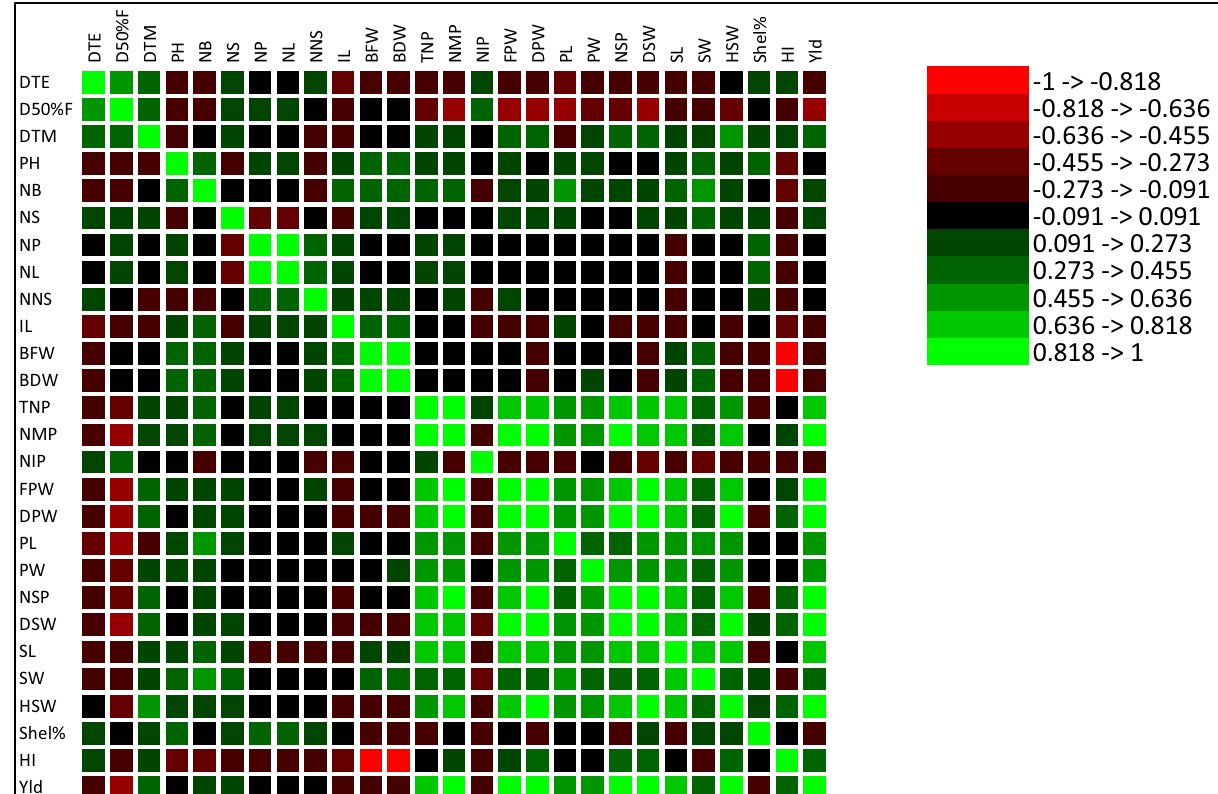
Figure 1. Correlation cluster heatmap showing graphical relationship among the 27 traits revealed by XLSTAT. Note: Red and yellow colour indicate negative and positive correlation, respectively among the tested traits. Darker the hue greater the relation between the traits and vice